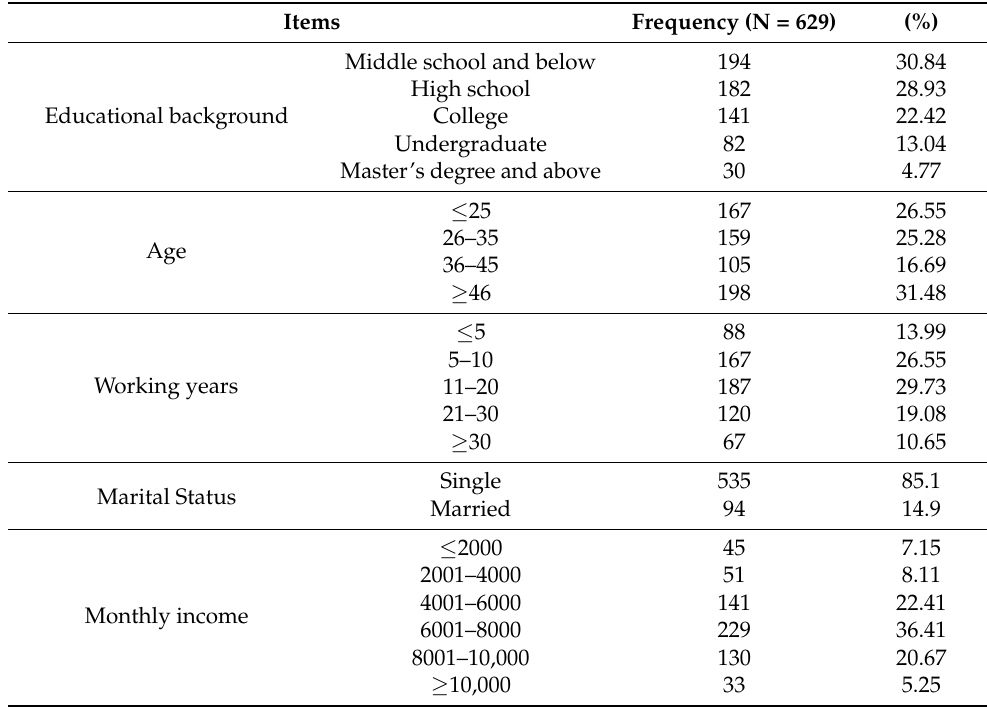
Table 1. Study participants’ demographic